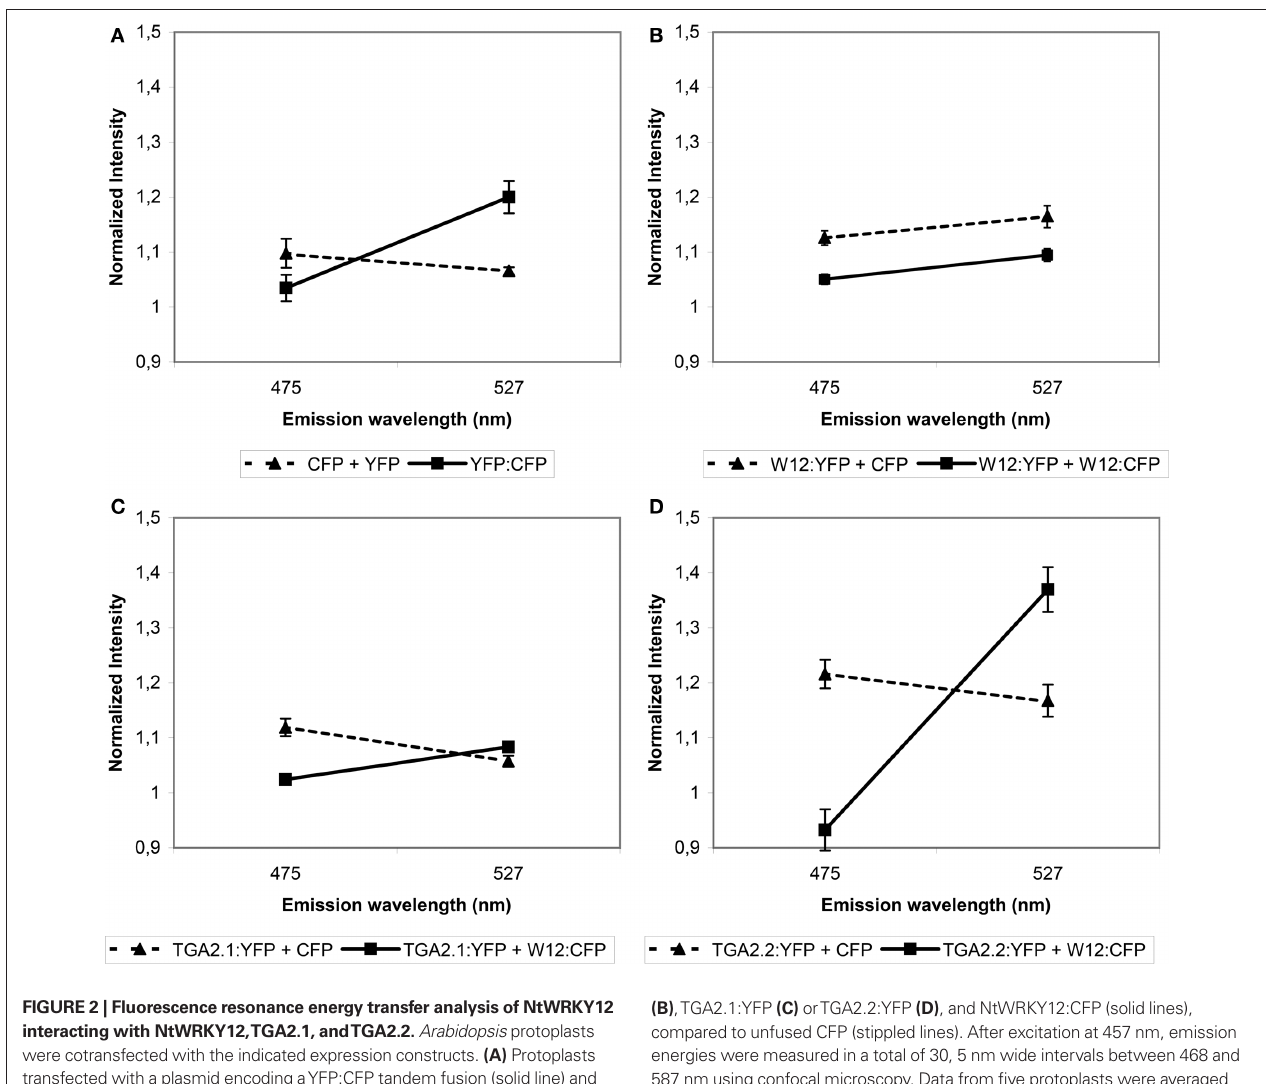
FiGuRe 2 | Fluorescence resonance energy transfer analysis of NtWRKY12 interacting with NtWRKY12, TGA2.1, and TGA2.2. Arabidopsis protoplasts were cotransfected with the indicated expression constructs. (A) Protoplasts transfected with a plasmid encoding a YFP:CFP tandem fusion (solid line) and protoplasts transfected with plasmids expressing unfused CFP and YFP (stippled line) were used as positive and negative FRET controls, respectively. (B–D) FRET data from protoplasts transfected with a combination of NtWRKY12:YFP